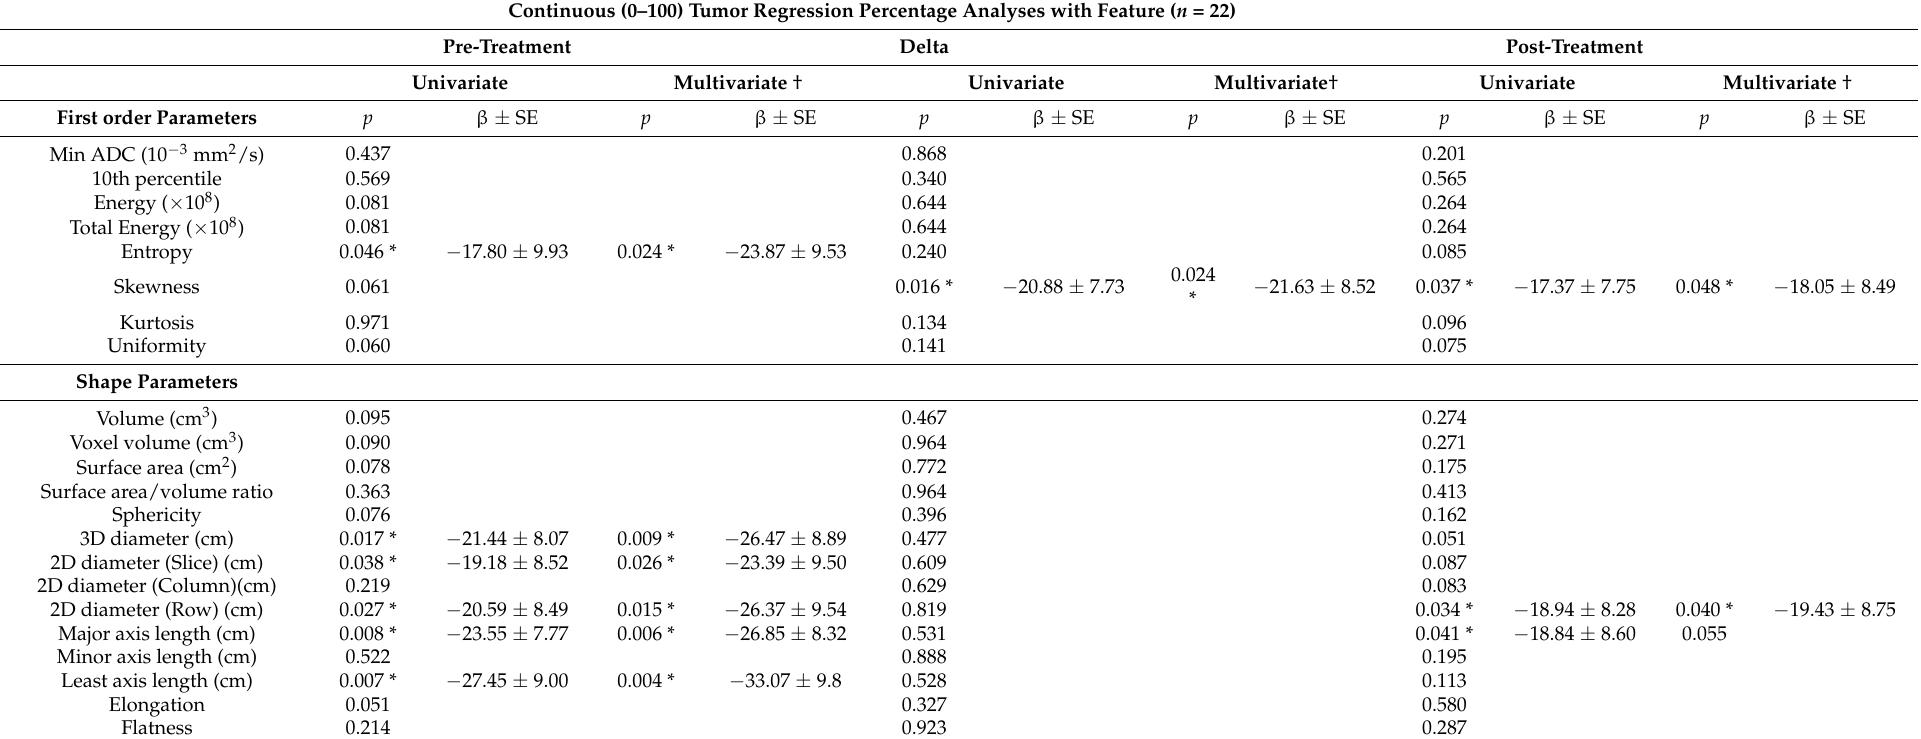
Table 4. Features analyses of the continuous (0–100) tumor regression percentage at pre-treatment, post-treatment, and delta time